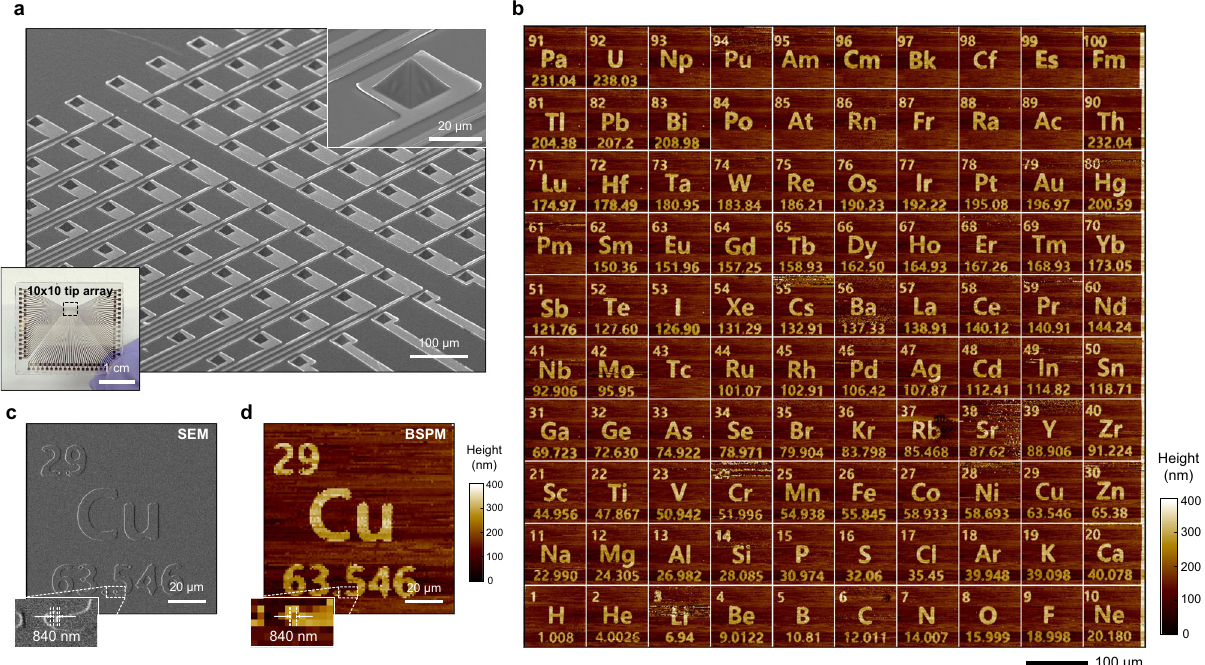
Fig. 6 BSPM measurement using the 2D 10 × 10 tip array. a SEM images and photograph of the tip array. b BSPM measurement of the periodic table patterns. SEM ( c ) and BSPM ( d ) images of the copper portion of the periodic table